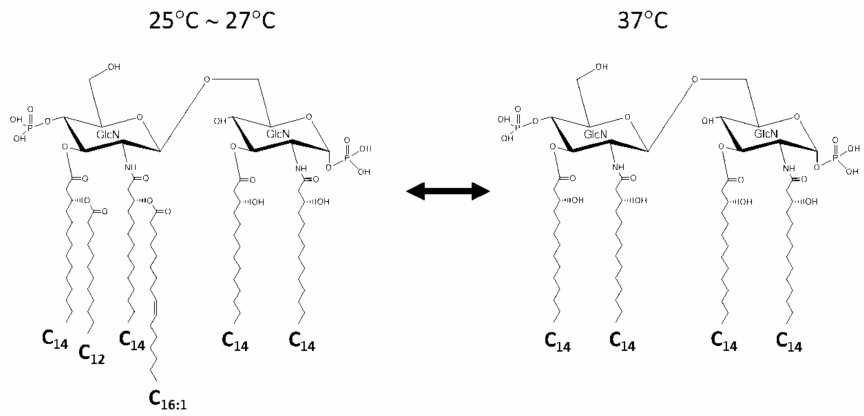
Figure 2. Structural conversion of Yersinia pestis lipid A by growth temperature (25 ~ 27 ◦ C: environ- mental temperature, 37 ◦ C: human body temperature).